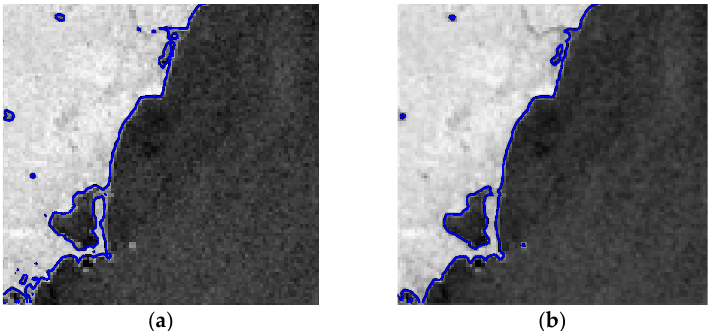
Figure 15. Local shoreline extraction results: ( a ) Traditional geometric active contour modeling method; ( b ) Proposed method.